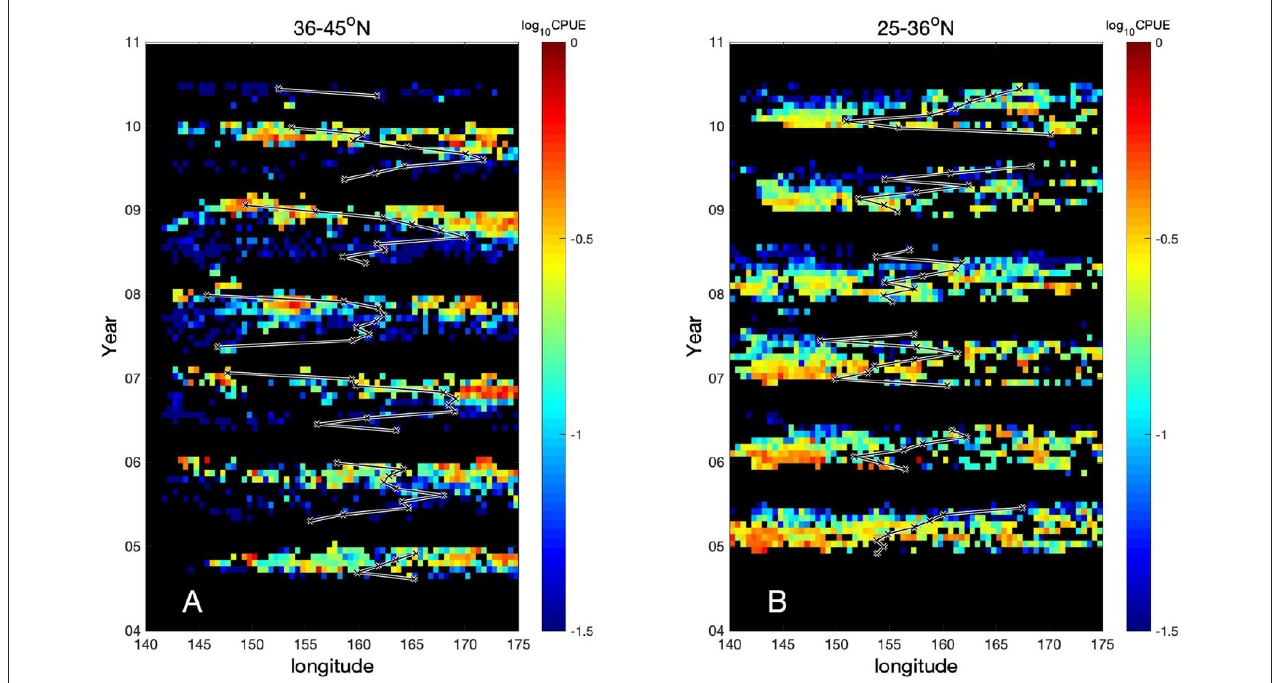
FIGURE 3 | CPUE as a function of longitude and time for (A) northern region 36–45 ◦ N and for (B) southern region 25–36 ◦ N. Black lines are the CPUE-weighted-mean zonal positions of longliners, which is computed by 6 long [longitude × CPUE /6 long CPUE], where 6 long is sum along longitude every month so that sum of CPUE /6 long CPUE is